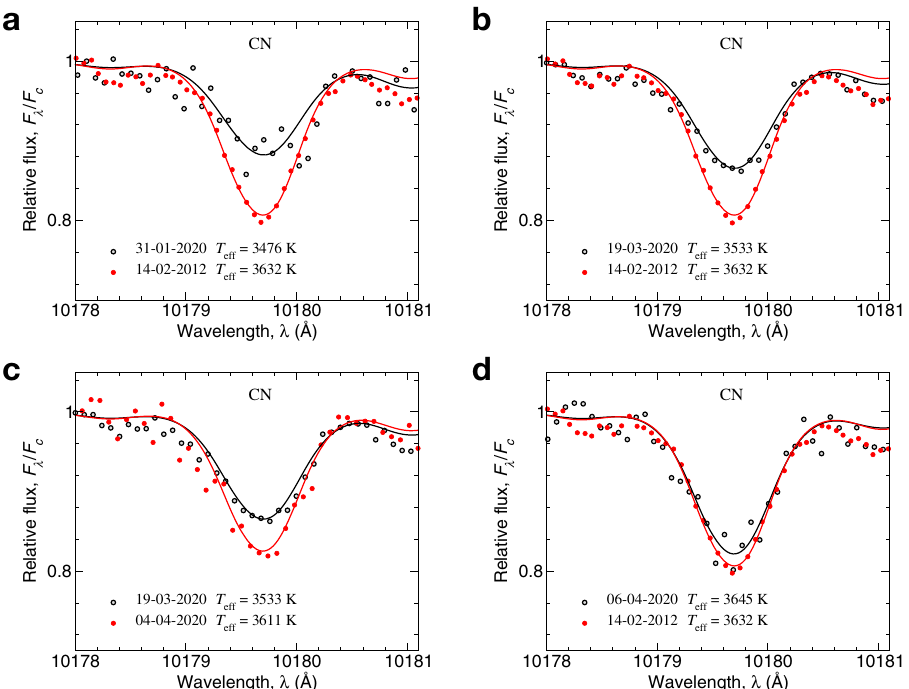
Fig. 5 The different strength of CN (cyanide) molecular line at 10,179 Å at different epochs can be explained by different temperatures at these epochs. Relative fl ux is calculated as a ratio of the fl ux at a particular wavelength ( F λ ) to the fl ux in continuum ( F c ). The spectral observations are shown by dots. Solid curves are theoretical spectra calculated at the particular temperature speci fi ed on each panel, convolved with the instrumental pro fi le. Carbon, nitrogen, and oxygen abundances are 8.43, 8.60, and 8.80 dex, respectively. This line was presented as an example. Similar behavior was found for other CN lines at λλ 10,223, 10,367, 10,376, and 10,377 Å. a The CN molecular line became stronger on 14-02-2012 compared to 31-01-2020. On the b , the comparison of CN lines observed on 14-02-2012 and 19-03-2020. c This CN molecular line is stronger on 19-03-2020 compared to 04-04-2020, while CN molecular lines look similar at both epochs 14-02-2012 and 06-04-2020 for which the temperature difference is only 13 K ( d ). Source data are provided as a Source Data fi